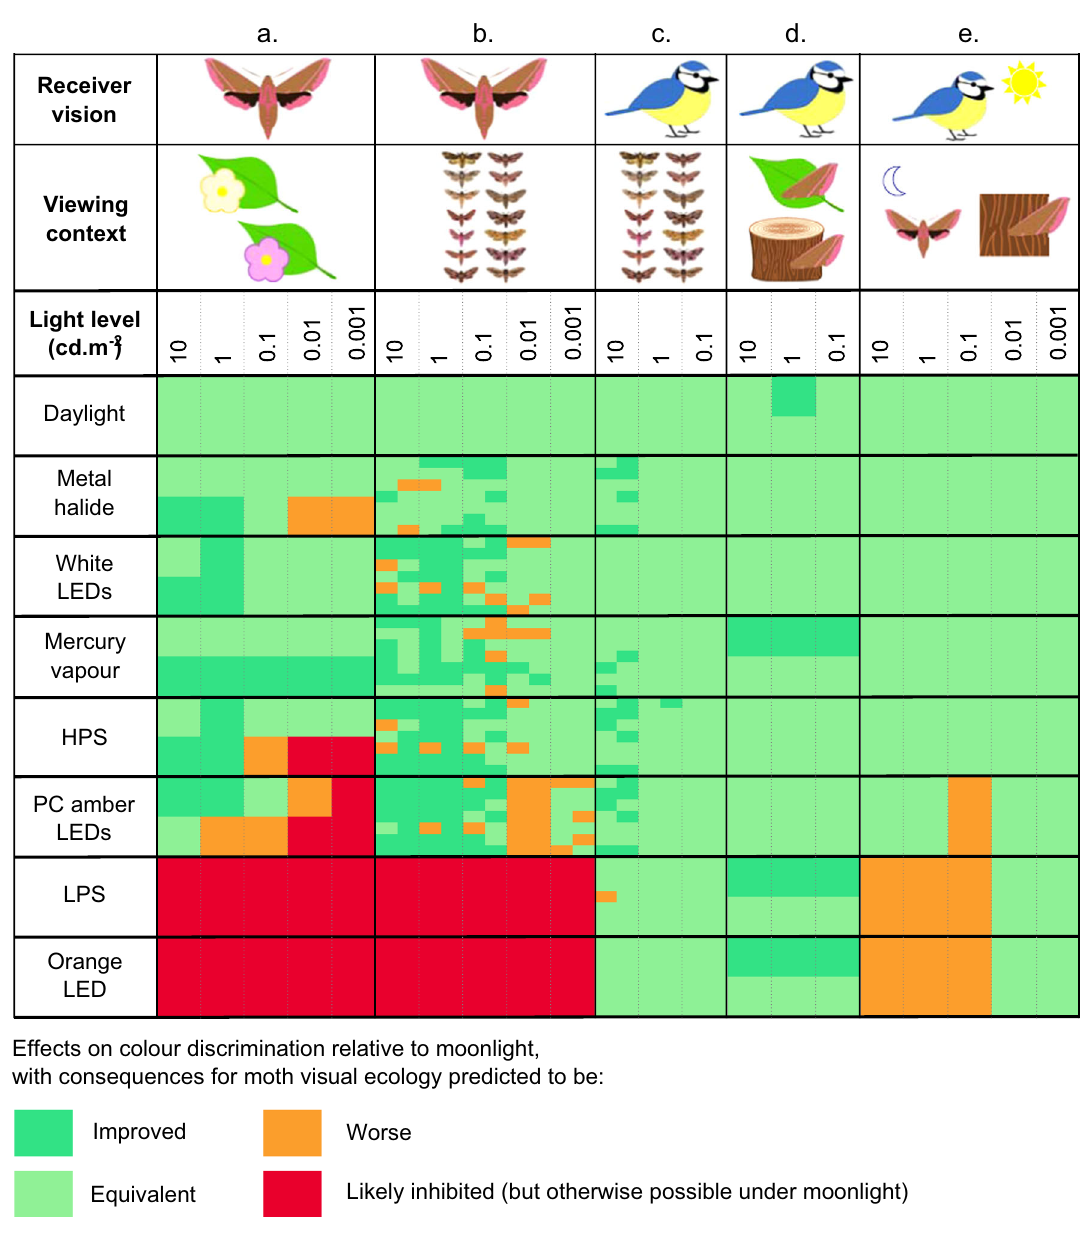
Fig. 1 Effects of arti fi cial lighting on colour perception, compared to moonlight at equivalent light levels. Lights are labelled as performing better (green) or worse (orange/red) than full moon conditions, from the hawkmoth perspective. Hawkmoth perception was modelled for: a contrast of white/yellow fl owers (top of cells), and pink/purple fl owers (bottom of cells) against natural foliage backgrounds; and b maximum internal contrast for intraspeci fi c signals (fore- and hindwings, 14 species positioned alphabetically in each cell). Blue tit perception was modelled for: c hawkmoth internal contrast (signalling, fore- and hindwings); d hawkmoth forewing camou fl age against green (top of cells) or brown (bottom of cells) natural backgrounds; and e hawkmoth background selection under arti fi cial light followed by blue tit detection under diurnal predatory search behaviour. Thresholds for ( a ) and ( d ) are set where there is no overlap between con fi dence intervals compared to full moon conditions. Thresholds in ( b ) and ( c ) are determined by the combined estimated effect of light type and the light:species interaction in models of the impact of lighting on maximum chromatic contrasts, with thresholds for difference from moonlight met when the absolute value of this estimate is greater than 1 Delta-S. Thresholds for ( e ) are based on statistical differences against full moon conditions representing colour mismatches >1 Delta-S. For white and PC amber LEDs, the statistical results in b , c and e are based on an LED in the middle of our CCT range (CCT = 3079 K) and PC amber Cree respectively, so conclusions may not apply to white LEDs with extreme CCT